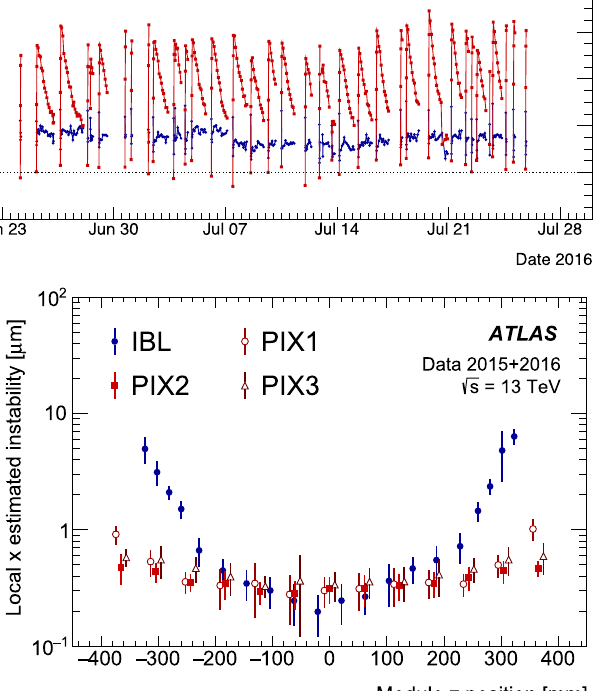
Fig. 12 Average correction of the IBL bowing magnitude, B x , (top), IBL and Pixel detector’s horizontal position, T x , (middle), IBL and Pixel detector’s vertical position, T y , (bottom) relative to the baseline alignment in 2016 pp collision runs between LHC technical shutdown period 1 and LHC machine development period 1. The correction is calculated every 20 min for the first 60 min of the data taking, and every 100 min for the rest of the data-taking period. Each connected series of points represents a continuous data-taking period